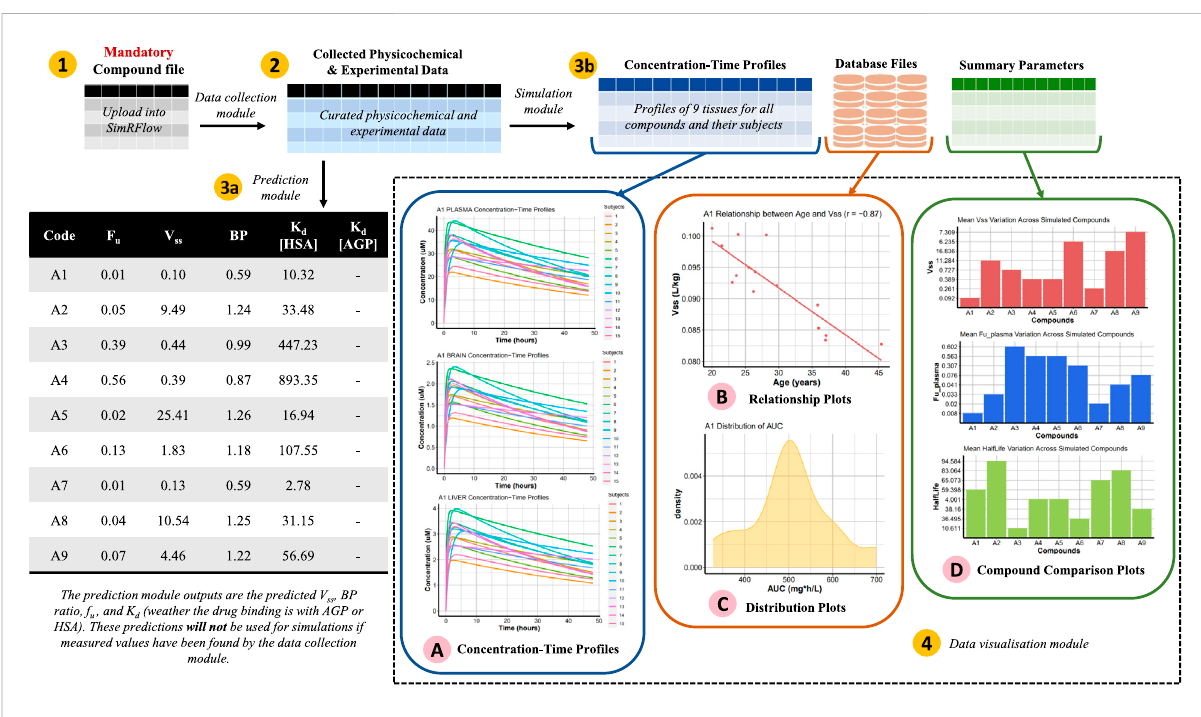
FIGURE 3 SchematicrepresentationofSimRFlow ’ sfunctionsbeingappliedontheexemplarcompound fi leinTable4(label1).Thedatacollectionmodule generates a table of the curated physicochemical and experimental data (label 2) which it uses to activate the prediction module (label 3a) or the simulation module (label 3b). The data visualisation module returns a range of plotting options for understanding the simulation outputs (label 4).